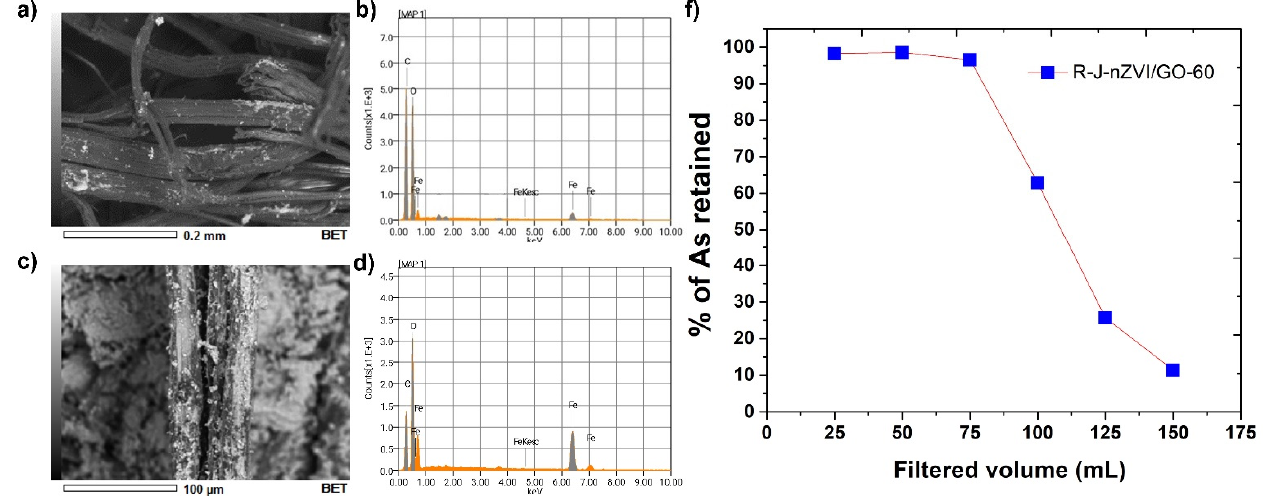
Figure 8. SEM micrographs and EDS elemental analysis, ( a , b ) RJ-nZVI/GO-60 test, ( c , d ) RJ-nZVI/GO-30, ( f ) retention percentage of the RJ-nZVI/GO-60 test.